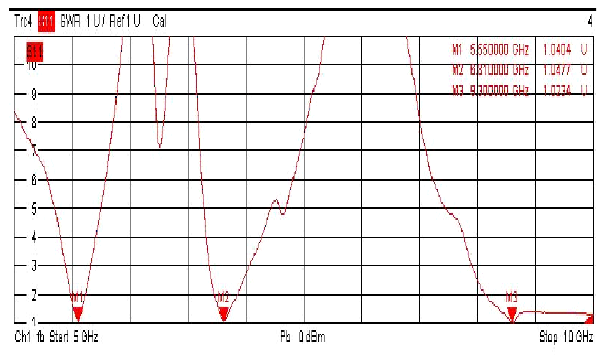
Figure 7: VSWR of experimentally measured proposed antenna .